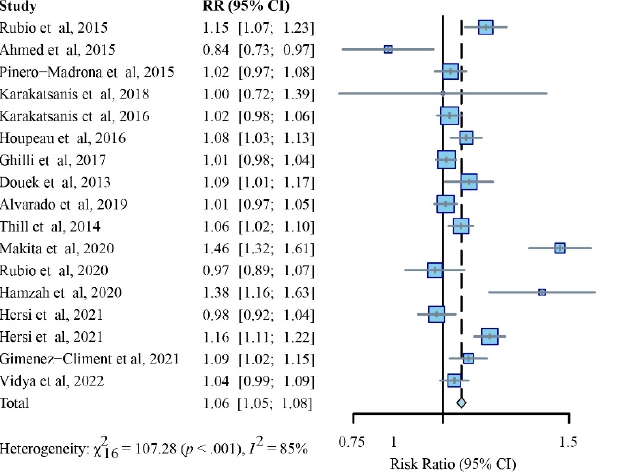
Figure 4. Relative risk (RR) analysis of SLN identification rates for SPIO versus standard method (random-effects model).